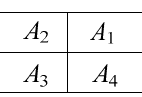
Figure 2. Four-quadrant aperture.